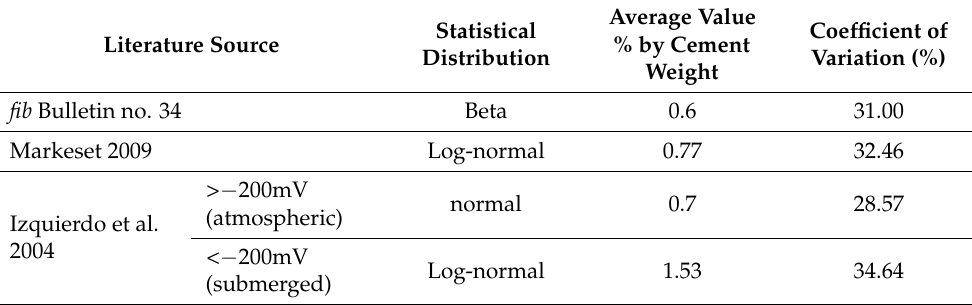
Table 1. Statistical distributions of the chloride threshold.